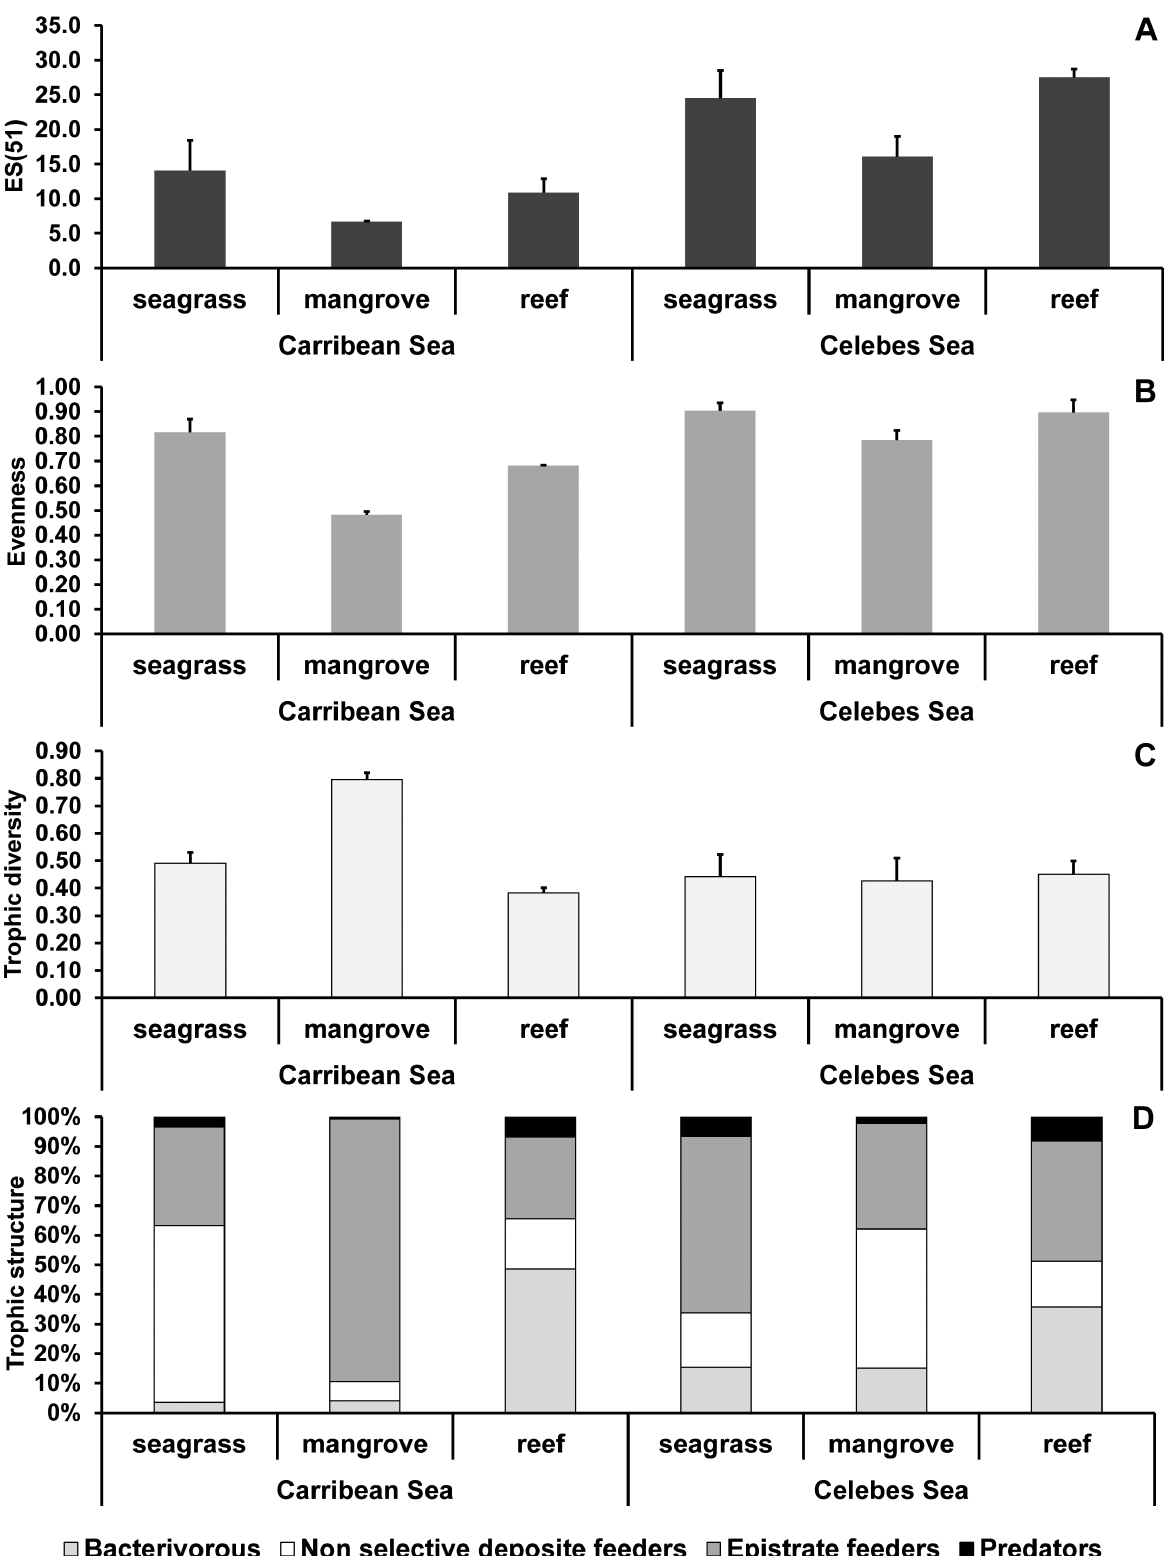
Figure 6. Nematode diversity. Illustrated are A) expected species number [ES(51)], B) evenness (Pielou’s J), C) index of trophic diversity (ITD) and D) trophic composition of nematode assemblages in seagrass, mangrove and reef habitats of the Caribbean, Red and Celebes Seas.